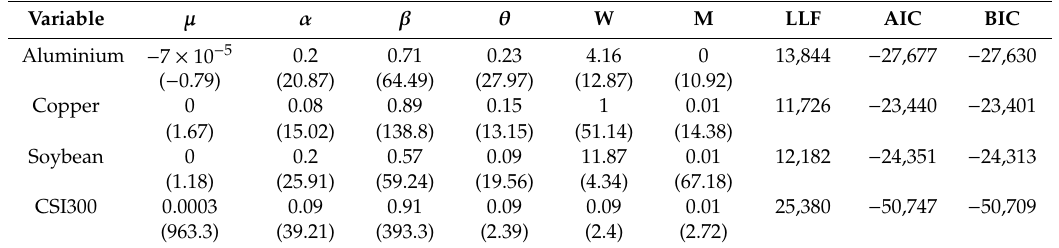
Table 5. Parameter estimate for the GARCH-MIDAS model with realized